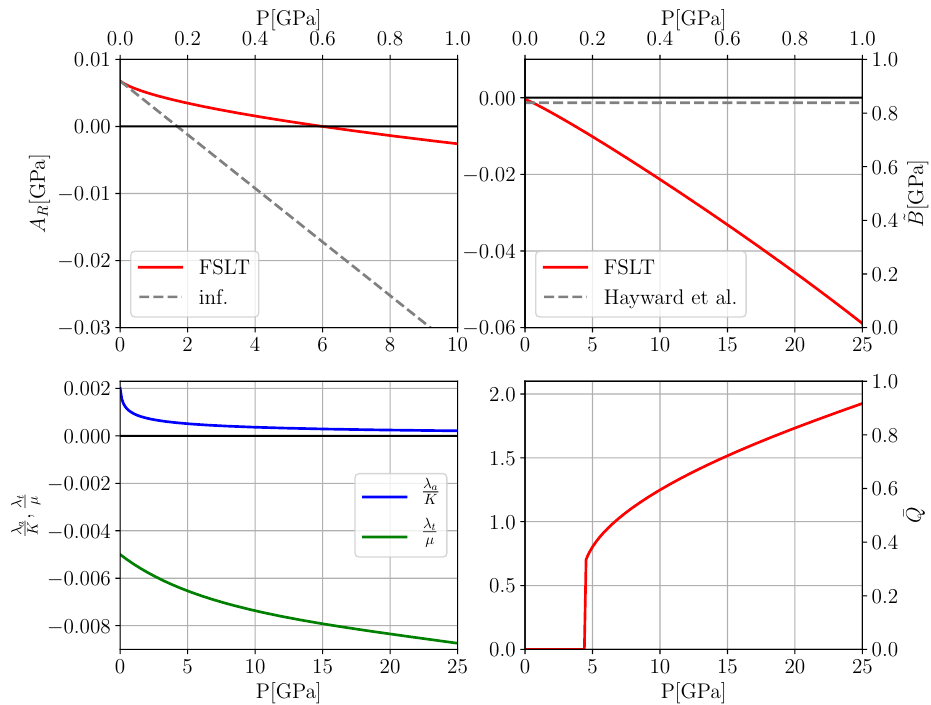
Figure 11. Upper left panel: pressure dependence of Landau parameters A R ( P ) as compared to the simple linear behavior of infinitesimal strain LT assumed in Equation (7a). Upper right panel: pressure dependence of ˜ B ( P ) . The dashed horizontal line indicates the corresponding value from the parametrization of Hayward et al. [19] taken at T = 186.5 K, which is slightly displaced from our limiting value at P = 0 since we are taking into account thermal softening of K ( P ) and µ ( P ) for room temperature. Lower left panel: pressure dependence of coupling parameters λ a ( P ) / K ( P ) and λ t ( P ) / µ ( P ) . Lower right panel: resulting behavior of the equilibrium order parameter ¯ Q ( P ) (right).